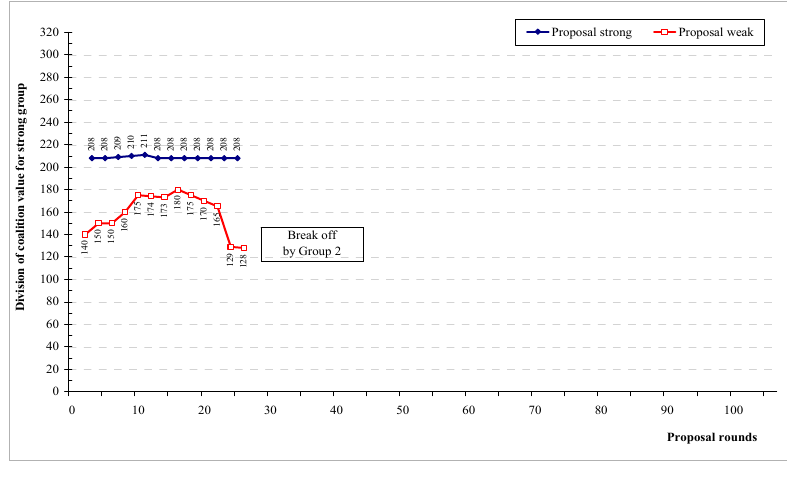
Figure A1. Session 5 in GER.